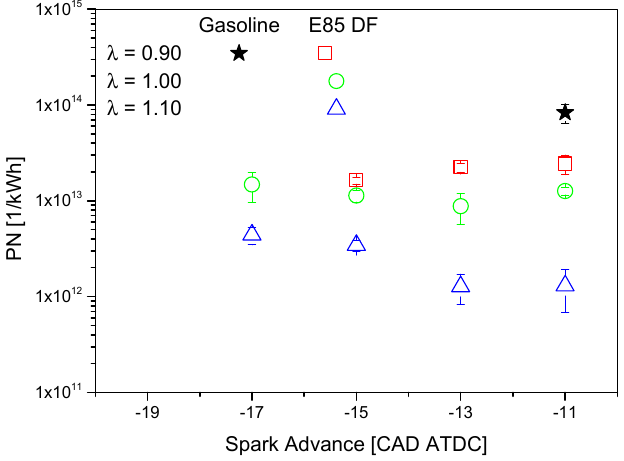
Figure 12. PN as a function of the spark advance for E85 DF.